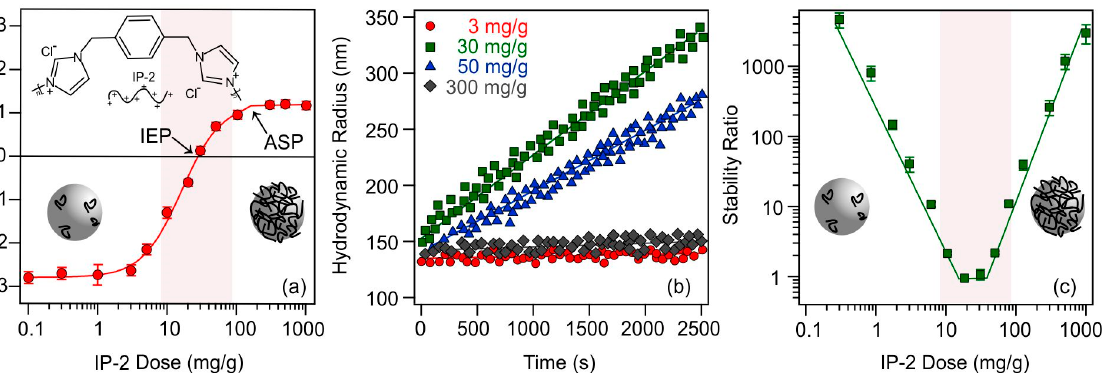
Figure 1. Electrophoretic mobility of SL at different IP ‐ 2 polymer doses: ( a ); hydrodynamic radius versus time ( b ); and stability ratios of SL particles as a function of the IP ‐ 2 dose ( c ). The measure ‐ ments were performed at pH 10 and at 10 mM ionic strength adjusted by KCl, while 10 mg/L SL concentration was applied. The mg/g unit refers to mg IP ‐ 2 per one gram of SL. The solid lines in ( a , c ) are eye guides, while in ( b ), they are linear fits to calculate apparent rate constants and stability ratios (Equation (4)) shown in ( c ).